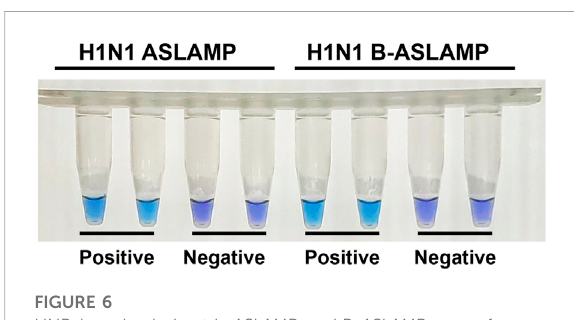
FIGURE 6 HNB-based colorimetric ASLAMP, and B-ASLAMP assays for H1N1 gene